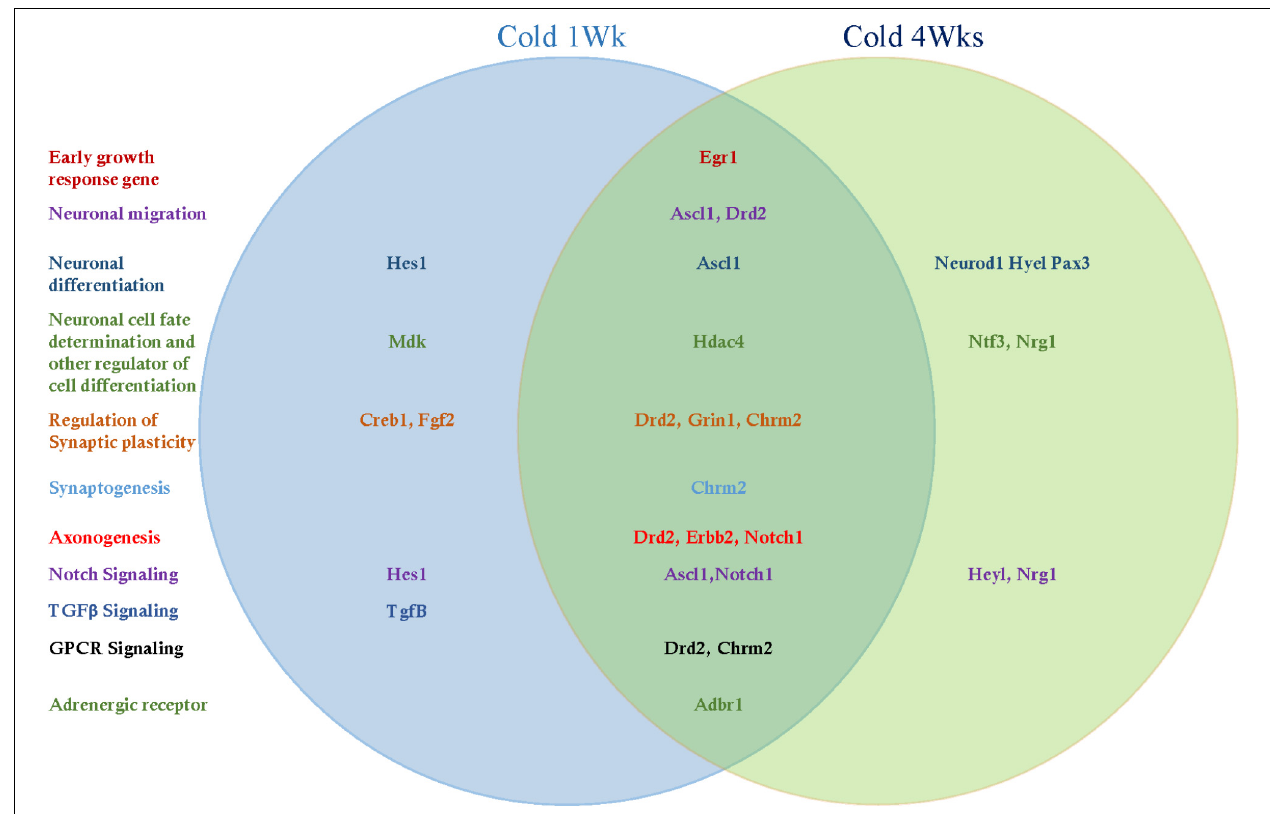
FIGURE 7 | The list of hippocampal mRNAs that significantly changed after cold challenge for 1 week or 4